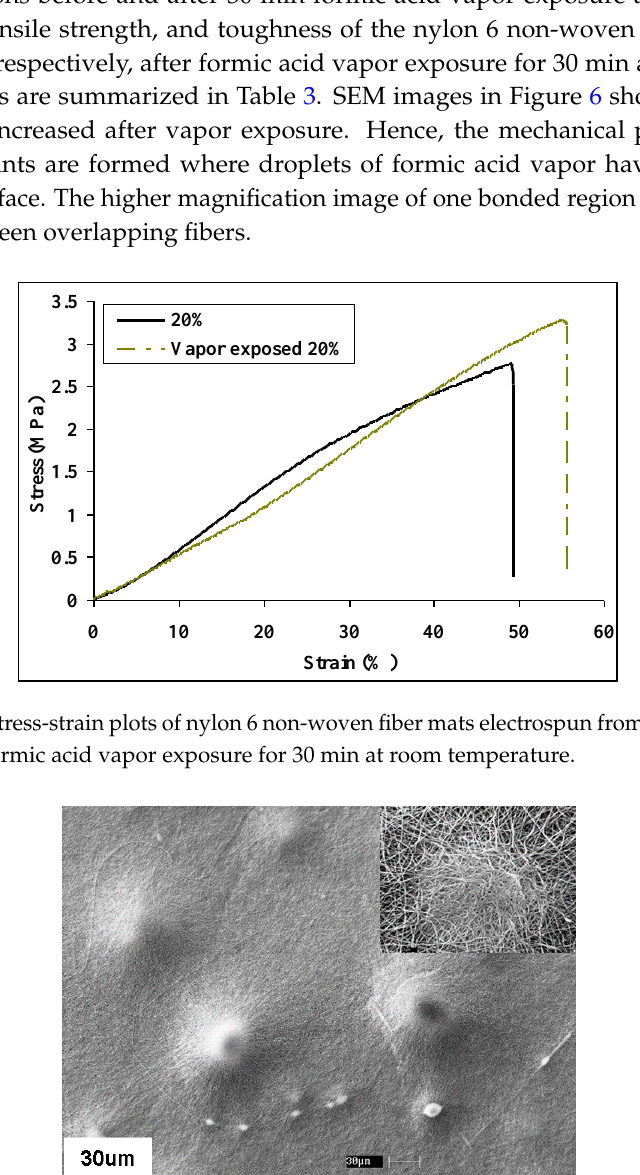
Figure 6. SEM imaging of nylon 6 non-woven fiber mats electrospun from 20 wt % solutions after formic acid vapor exposure for 30 min at room temperature.